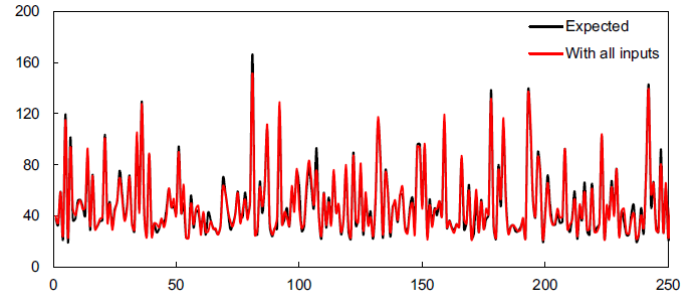
Fig. 7 Comparison of BP neural network prediction results and actual values under colour